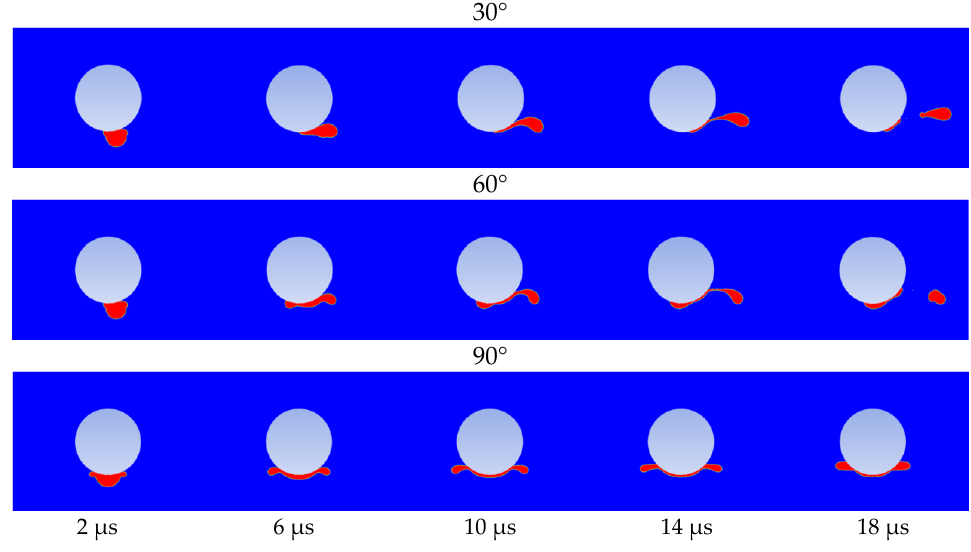
Figure 16. Dynamic evolution diagram of droplet impact